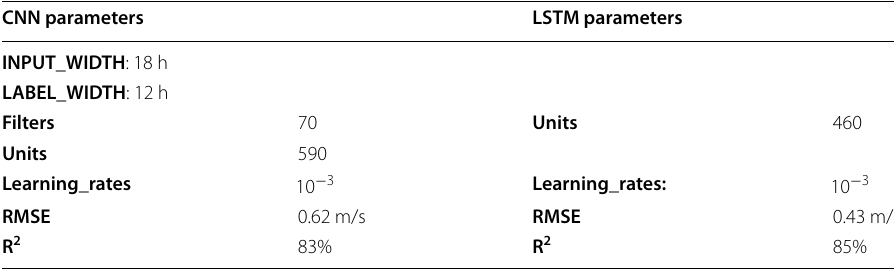
Table 2 CNN and LSTM parameters and performance for W x forecasting CNN parameters LSTM parameters